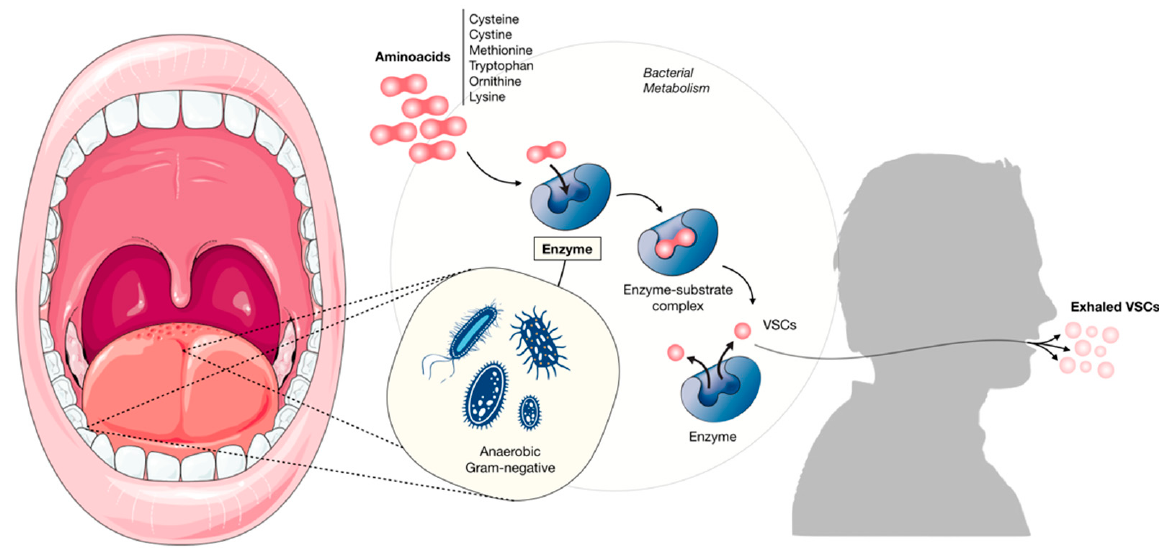
Figure 1. Pathophysiology of halitosis. Bacteria present in the gingival pockets and the dorsum of the tongue metabolize amino acids through enzymes into volatile sulfur compounds that are ex- haled.